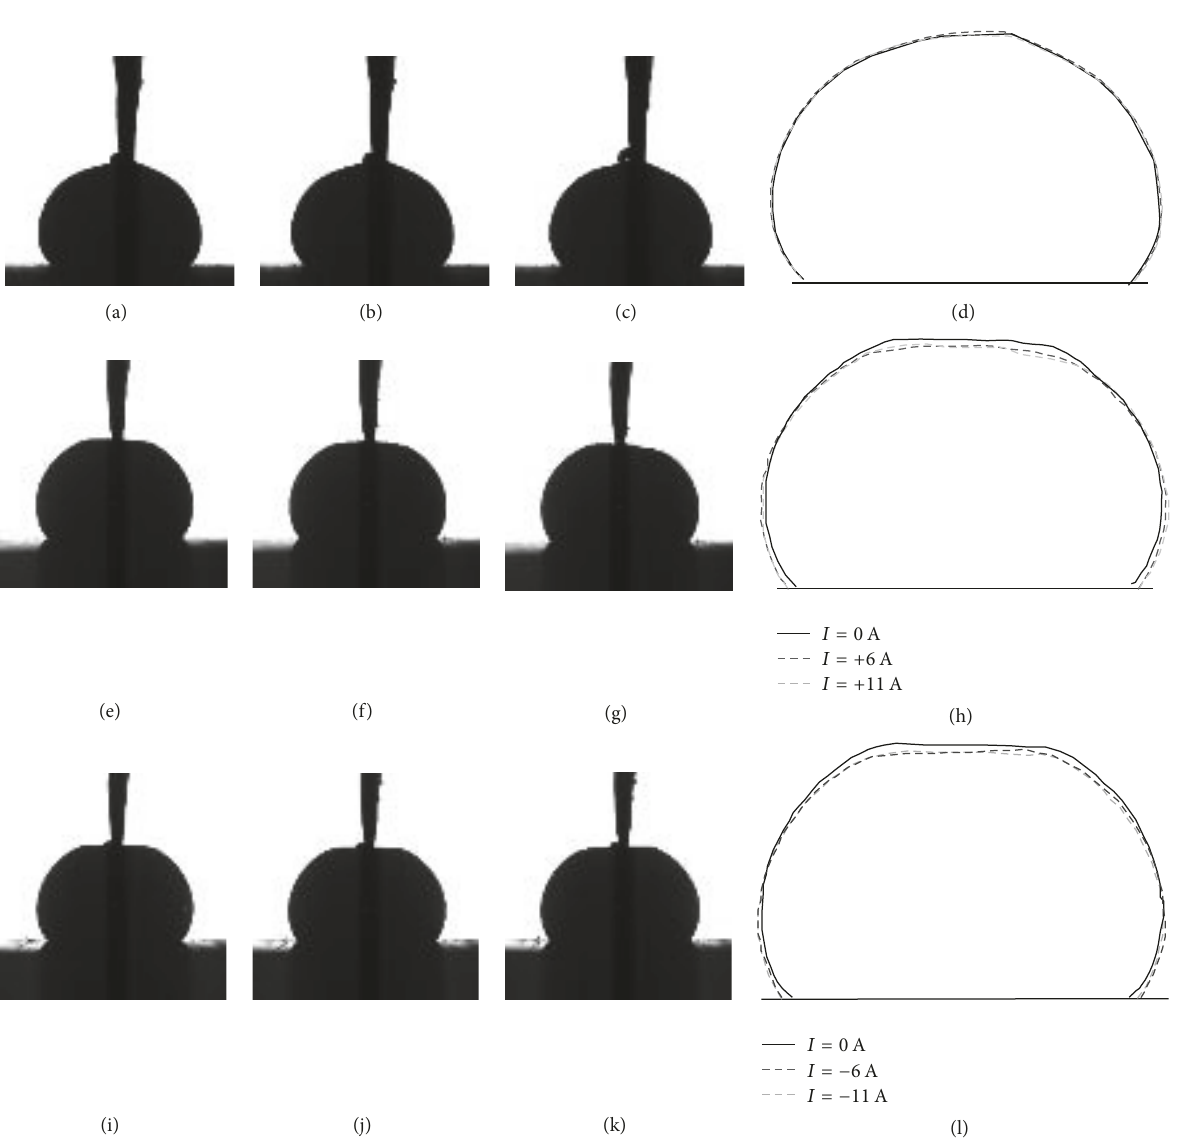
Figure 3: Typical liquid Ga–In–Sn drop shapes on Cu substrate under different conditions. Without DC after different standing time of (a) 5 min, (b) 35 min, and (c) 65 min, the three aforementioned drop shapes are amplified and overlapped in Figure (d). With positive DC (e) 0 A, (f) 6 A, and (g) 11A, the three aforementioned drop shapes are amplified and overlapped in Figure (h). With negative DC (i) 0 A, (j) 6A, and (k) 11A, the three aforementioned drop shapes are amplified and overlapped in Figure